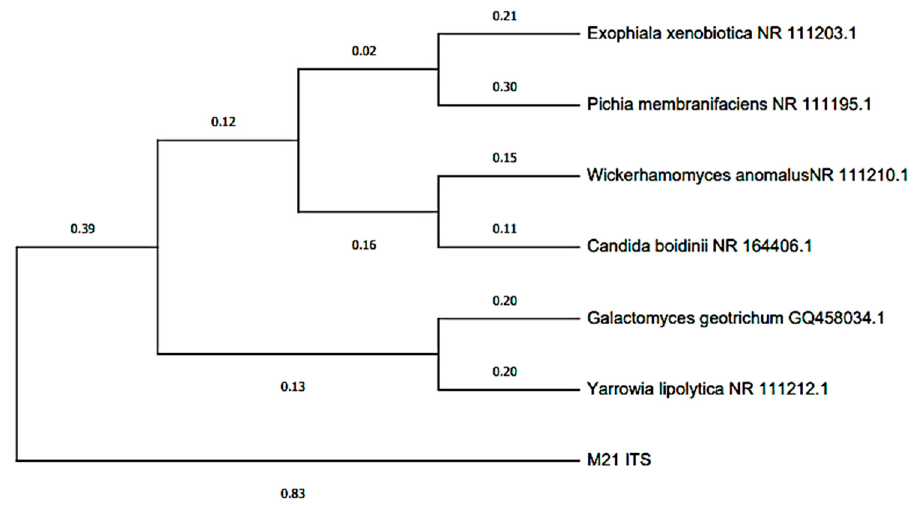
Figure 5. Dendrogram based on the ITS regions of the rDNA regions of a culture of Wickerhamomyces anomalus isolated from the MCC anode plate with pineapple substrate.